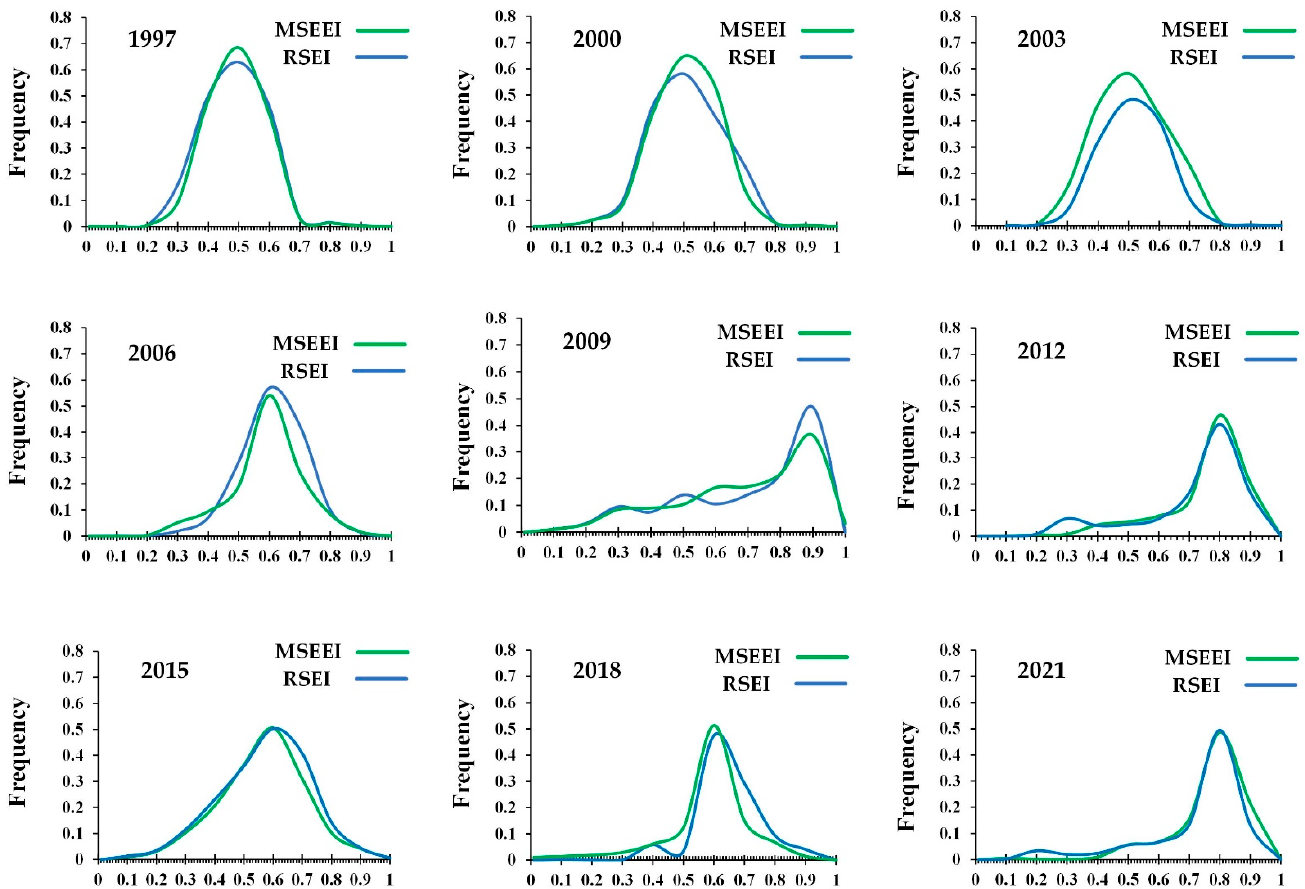
Figure 3. RSEI and MSEEI index frequencies in 1997, 2000, 2003, 2006, 2009, 2012, 2015, 2018, and